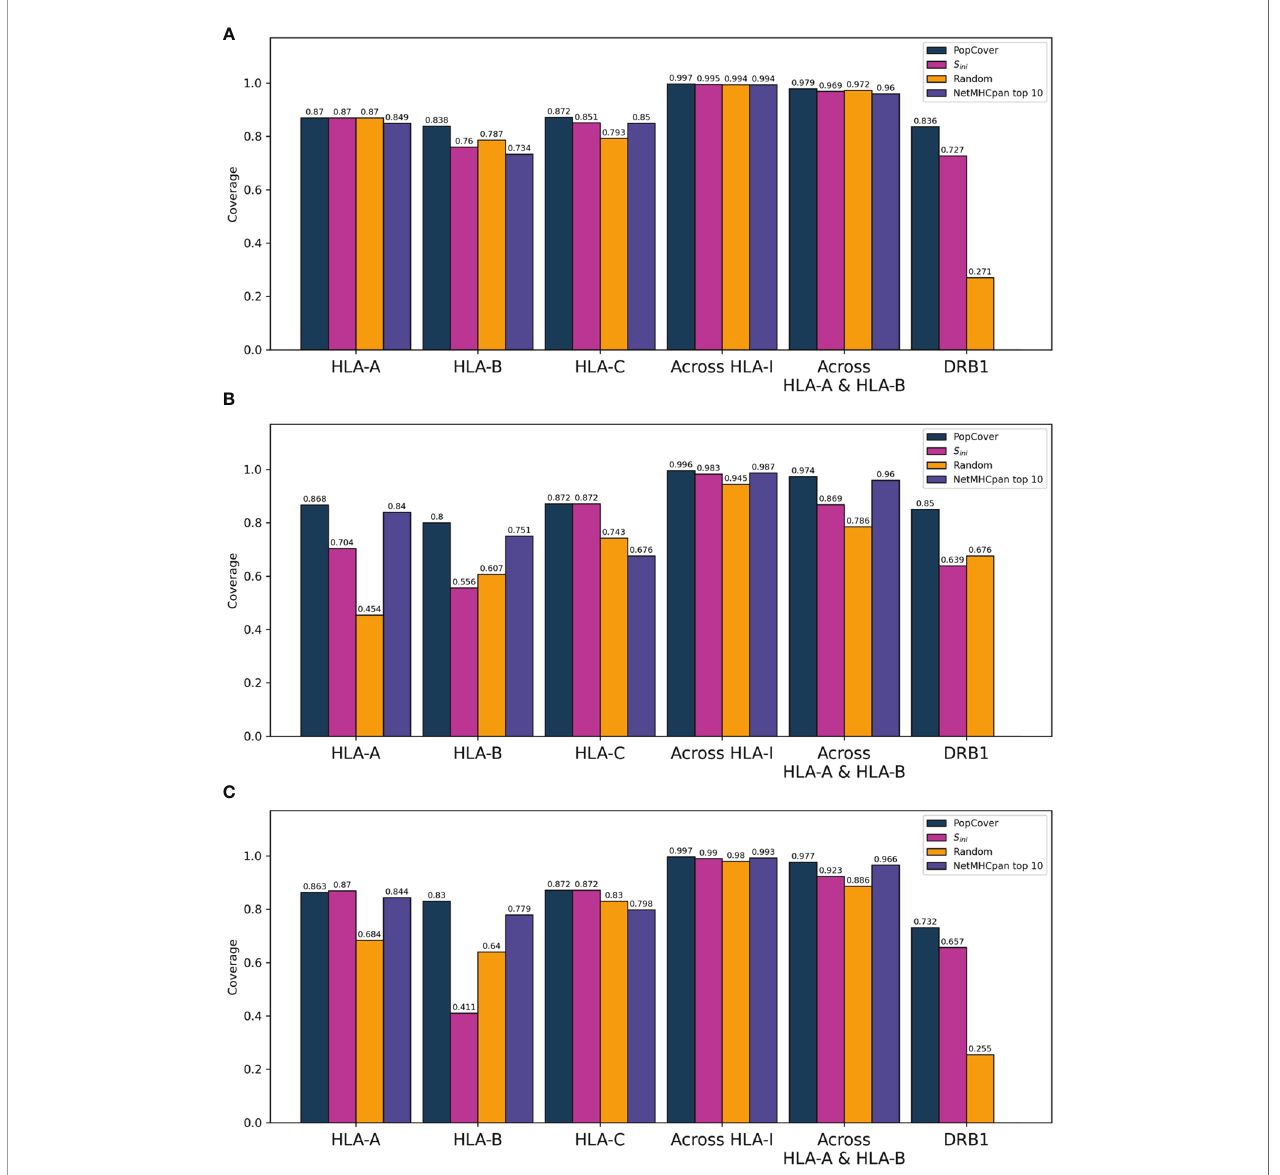
FIGURE 4 | Population coverage of peptide sets selected by the PopCover, S ini , Random, and NetMHCpan top 10 methods for the three SARS-CoV-2 protein sets ( A : S protein, B : N protein, C : ORF3a protein). Each bar chart shows the coverage estimated based on the three individual HLA-I loci (HLA-A, -B, and -C), the combined “ across HLA-I ” coverage, the coverage across only HLA-A and HLA-B, and lastly the HLA-II DRB1 locus. Note that the NetMHCpan top 10 peptides only target HLA-I alleles, hence no DRB1 coverage bars are included for this selection